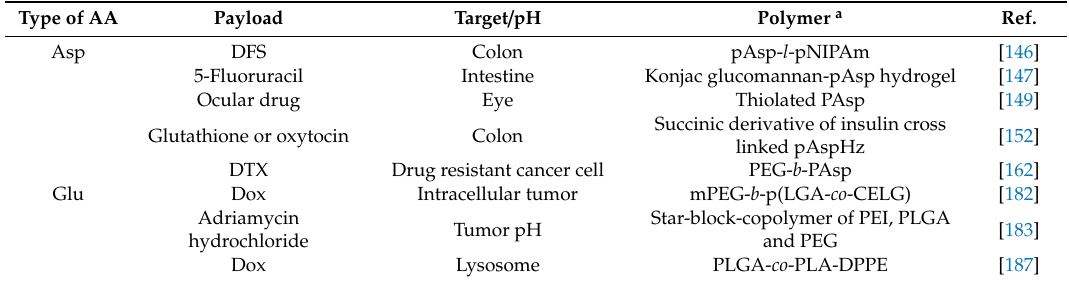
Table 4. Anionic amino acid derived polymers for pH-responsive drug